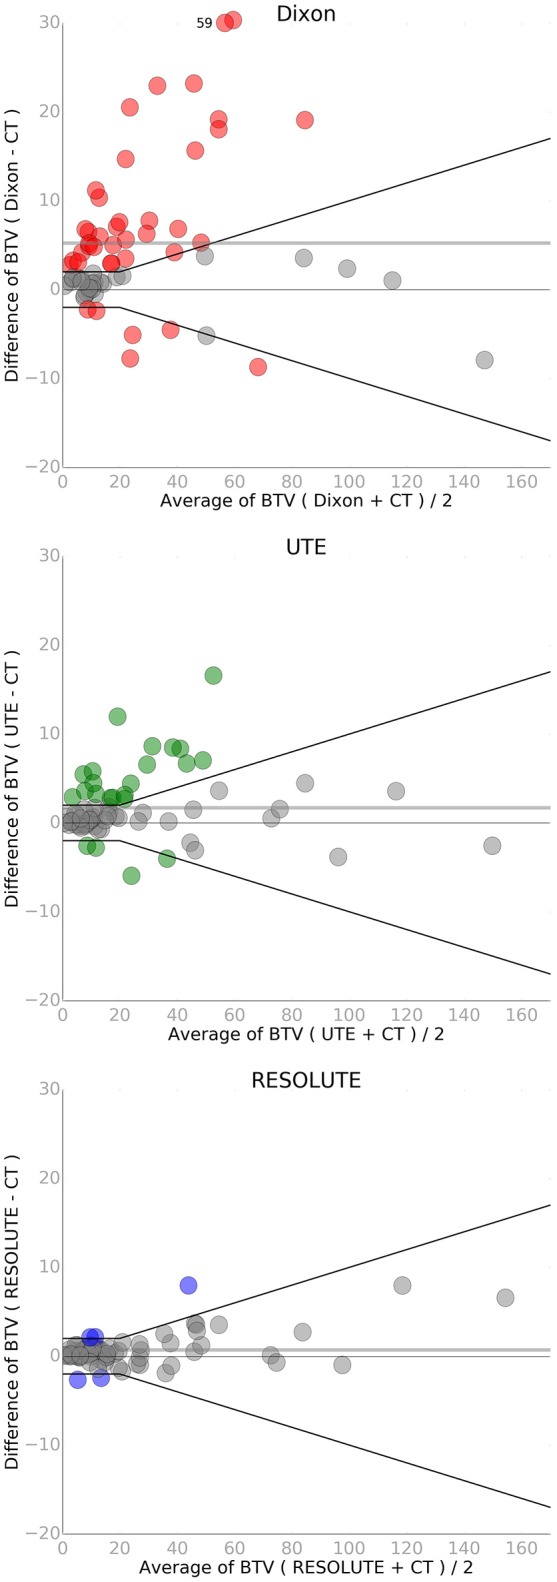
Bland-Altman plot of biological tumor volume (BTV in mL) for each of the three MR-AC methods against the reference standard CT-AC. A single point has been moved (from y = 59 to 30) to fit within the y-axis on the Dixon plot. The black lines indicate the acceptance criteria of BTV of ±2 mL or 10%. Points that exceed the criteria have been colored. The solid gray line indicates the mean value.